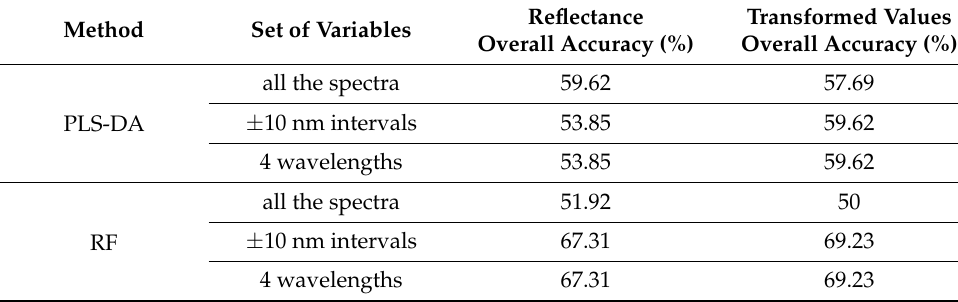
Table 5. Classification model overall accuracy (%) as a performance indicator.